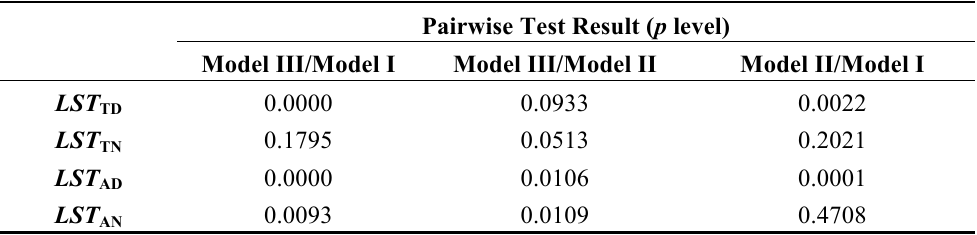
Table 5. Significant test between the different estimation values of daily mean air temperature using the three model types with the MODIS LSTs as the